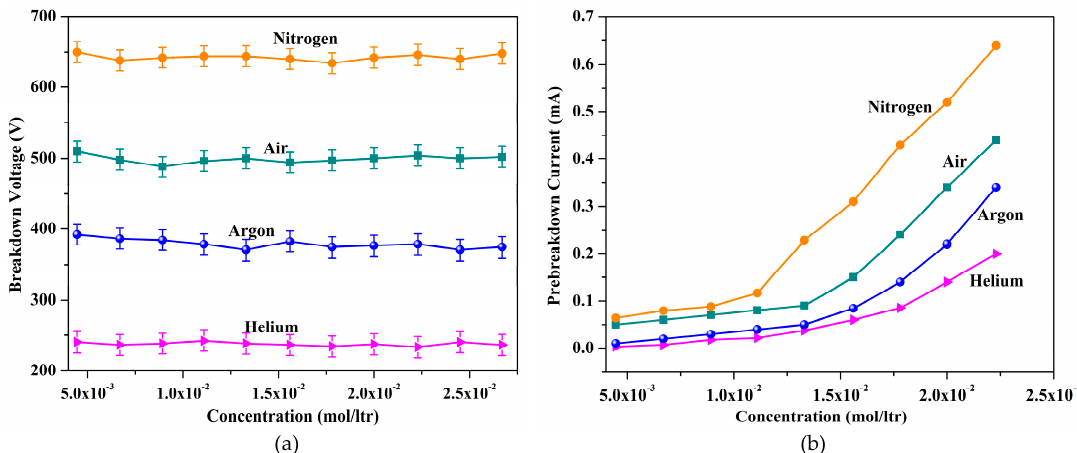
Figure 5. ( a ) Gas concentration vs. breakdown voltage, which shows that the breakdown voltage of the gas was independent of the gas concentration, and ( b ) discharge current increased as a function of concentration due to increasing gas molecules available for conduction.